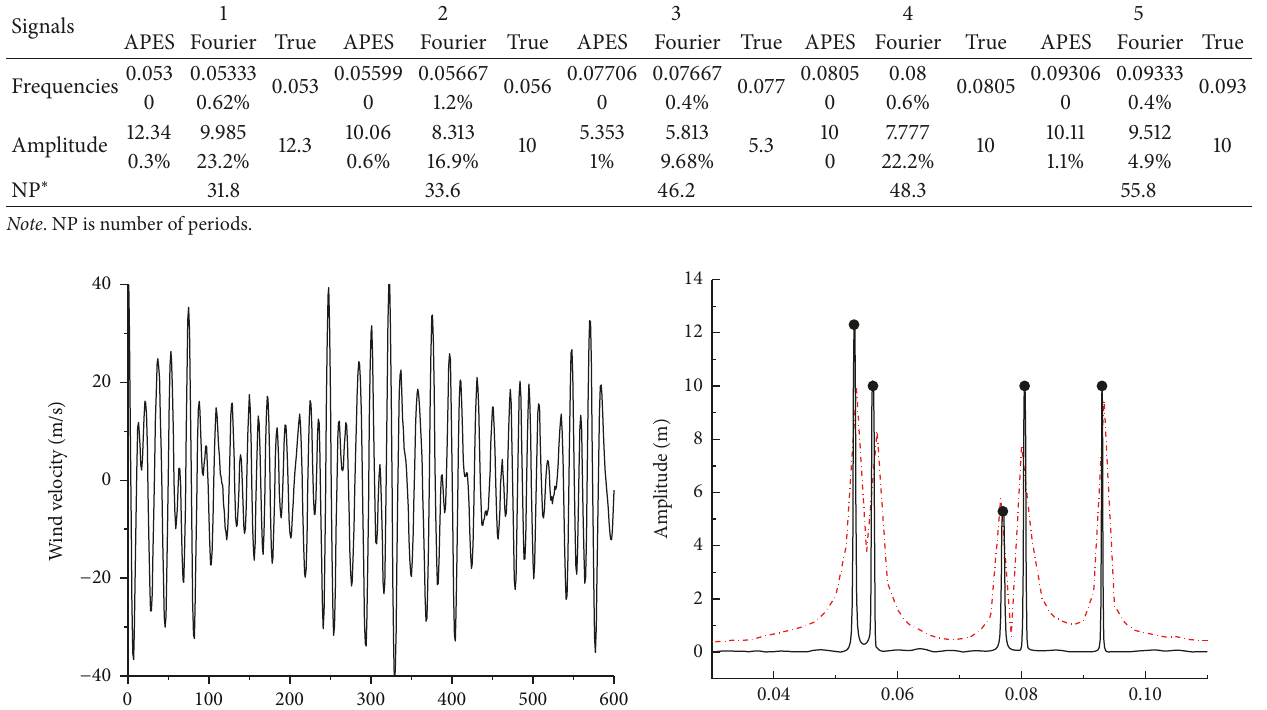
Table 1: Amplitude spectral identified for test signal.